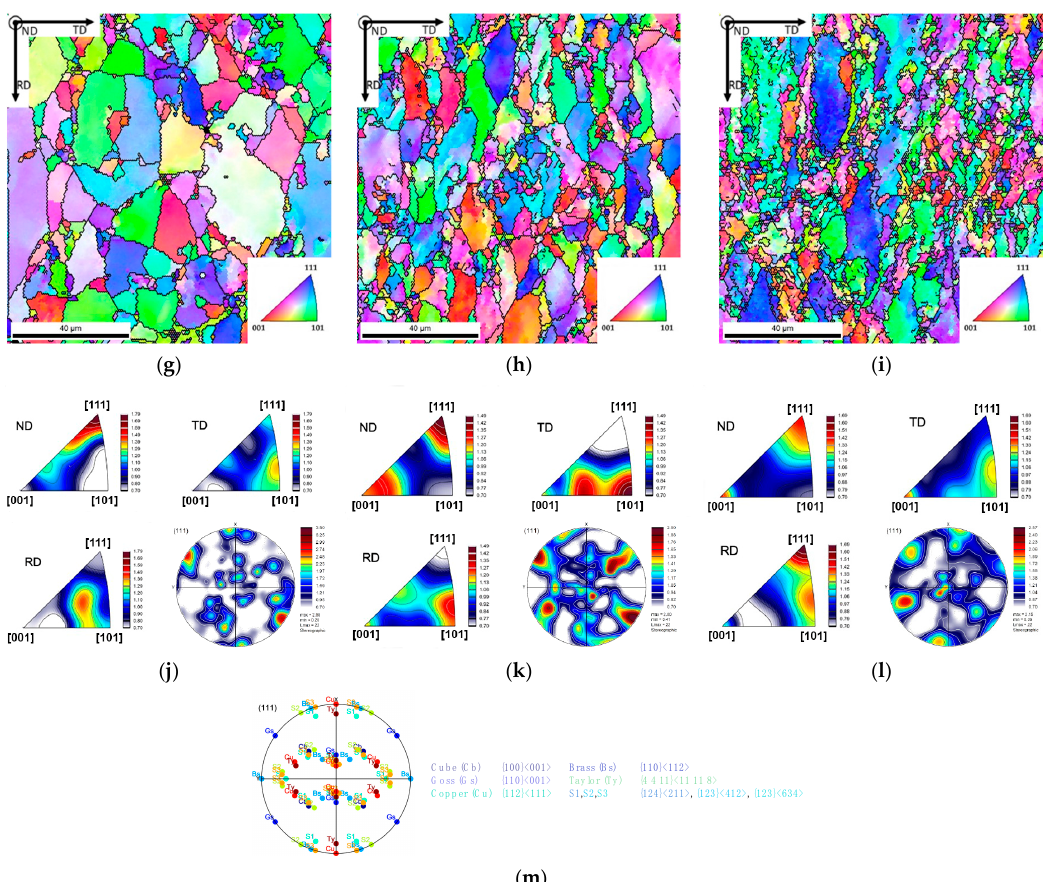
Figure 12. ( a – c ; g – i ) IPF maps and ( d – f , j – l ) IPF and [111] PF of the cold rolled ( a – f ) Al and ( g – l ) Al/CNT samples, deformed with strains of ( a , d , g , j ) 0.11, ( d , e , h , k ) 0.36, and ( c , f , I , l ) 0.69. ( m ) Identification of rolling texture components in [111] pole